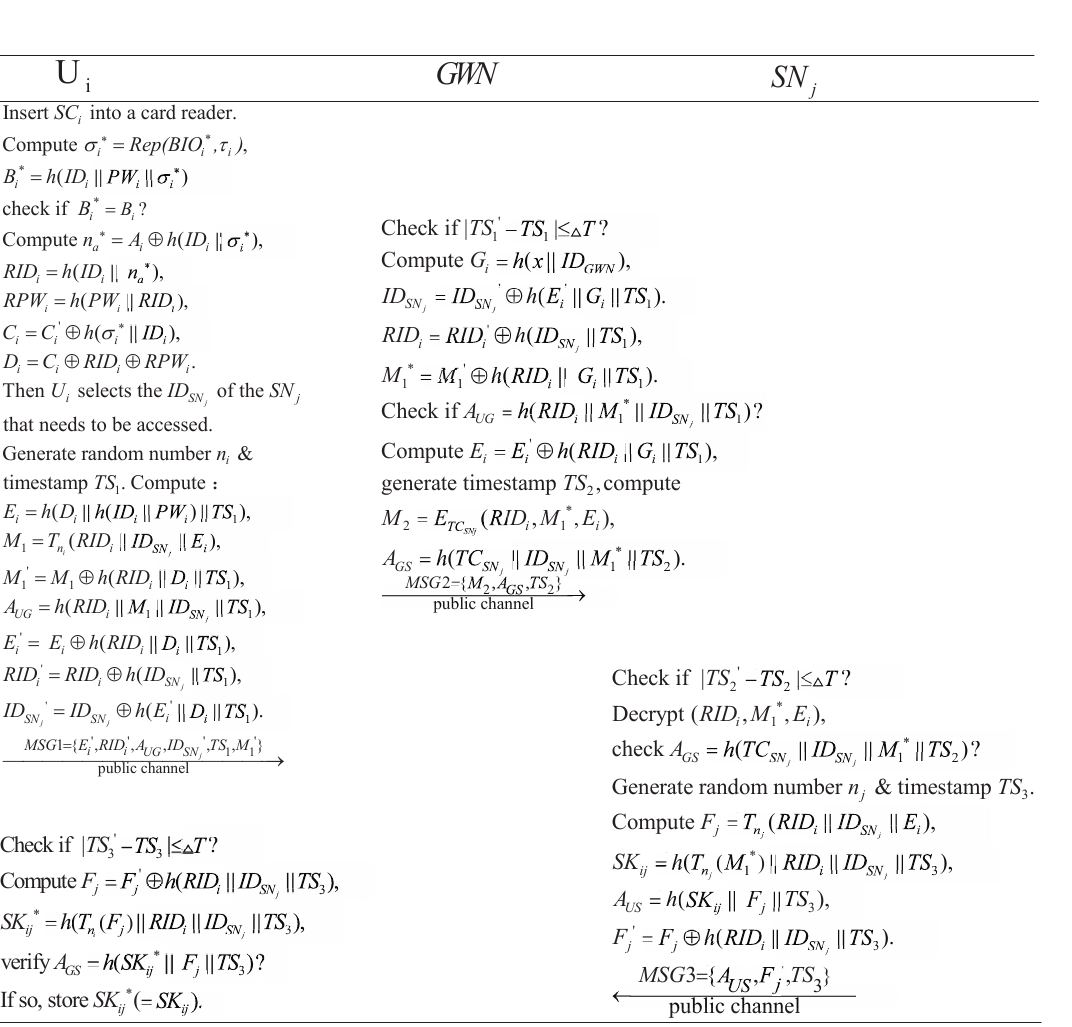
Figure 3. Login and authentication